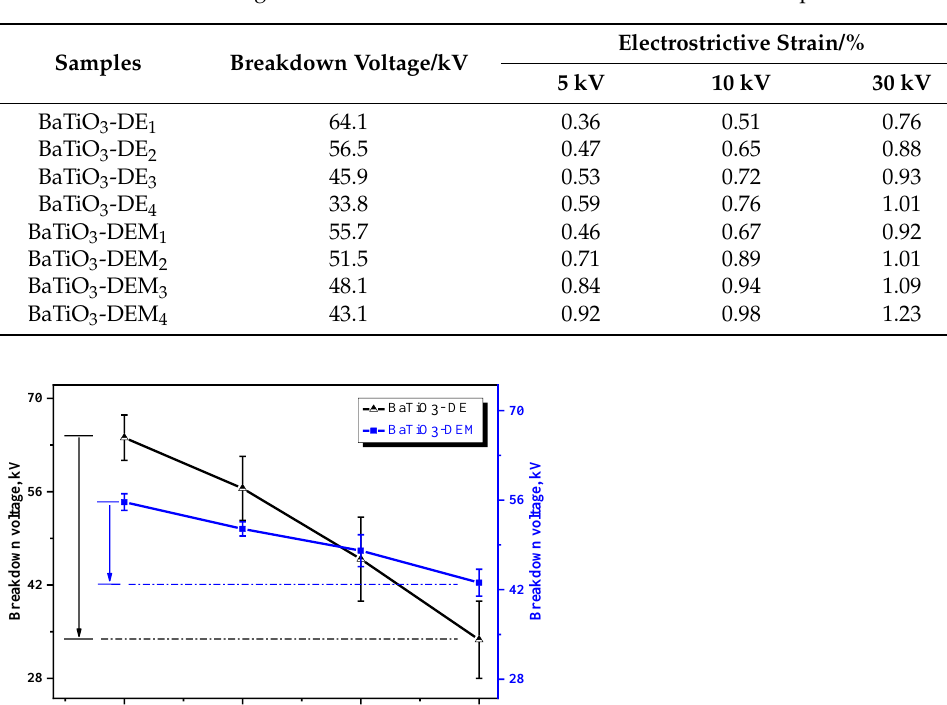
Table 8. Breakdown voltage and electrostrictive strain between two kinds of samples.